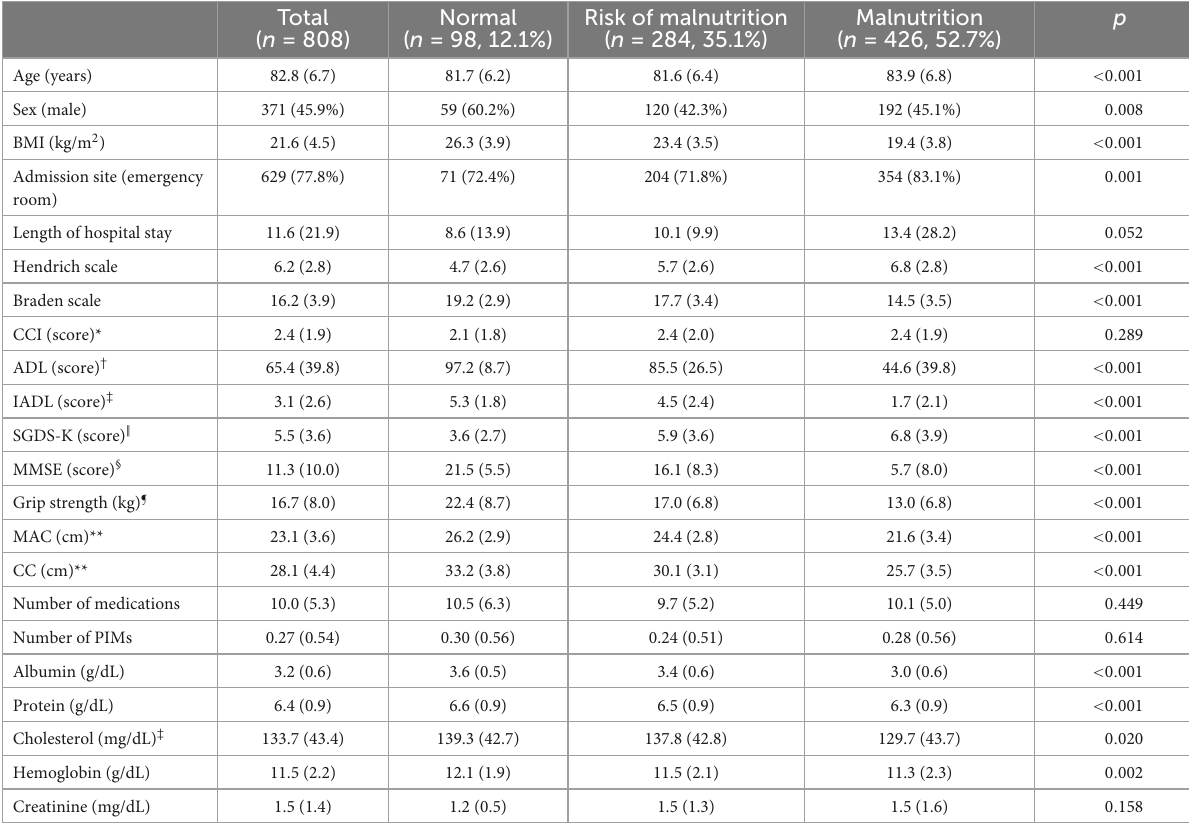
TABLE 1 General patient characteristics and results of the comparison of patients’ nutritional status assessed by MNA.